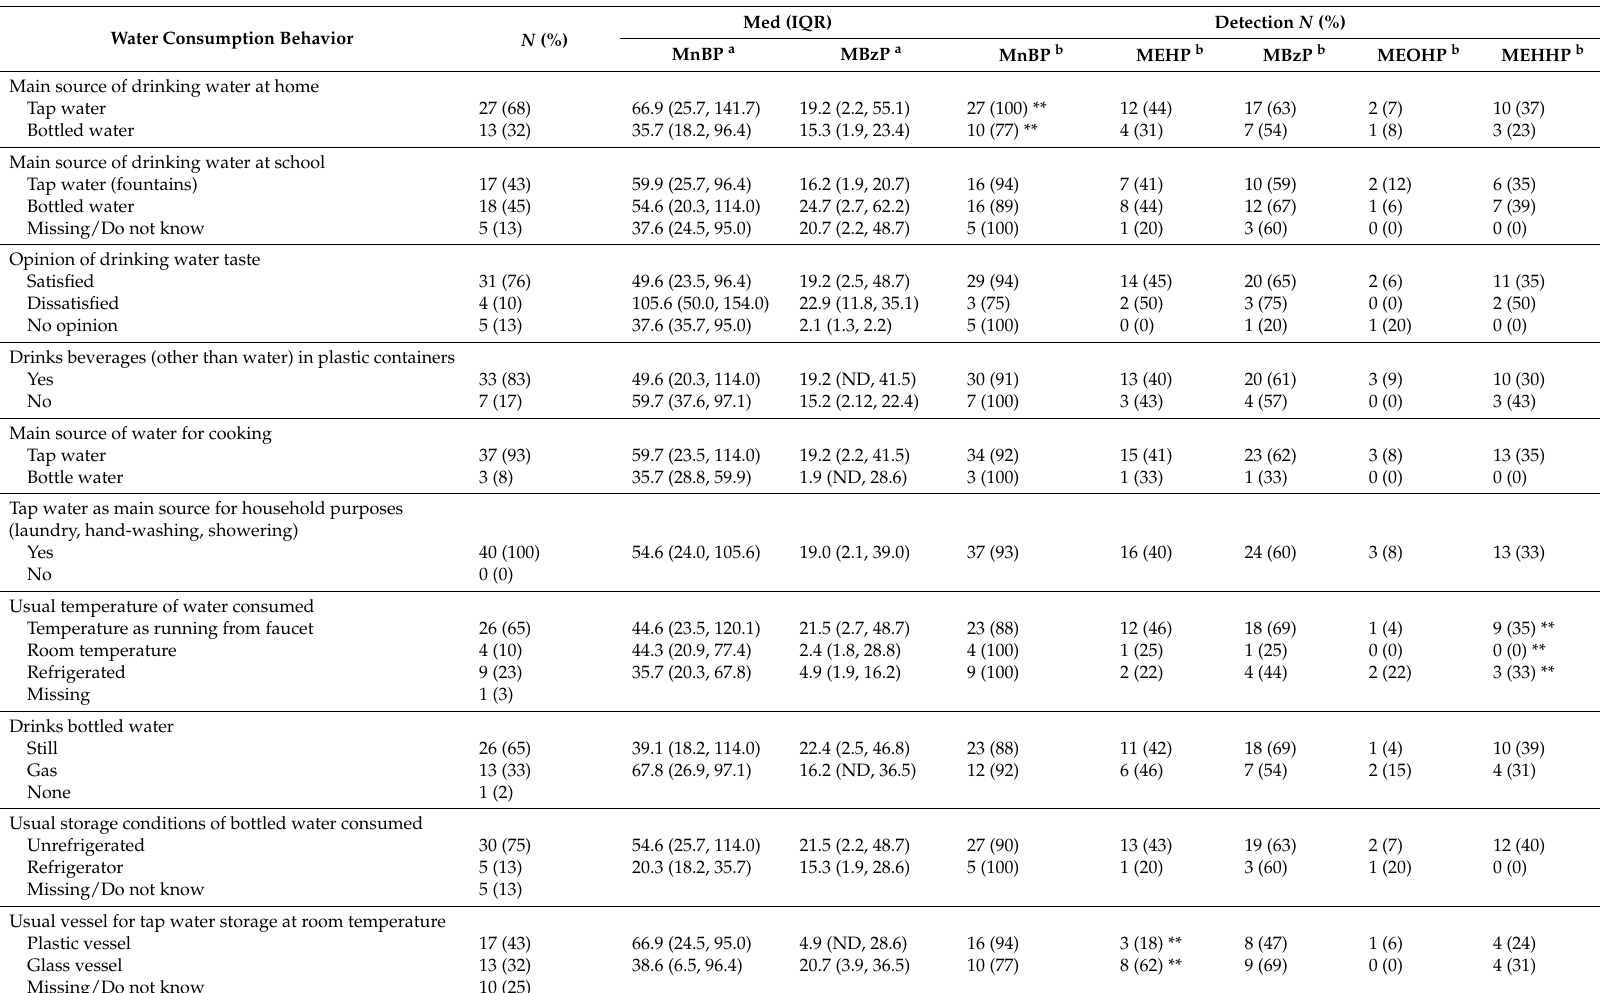
Table 3. Metabolite detection and creatinine-adjusted concentrations ( µ g/g creatinine) by water consumption